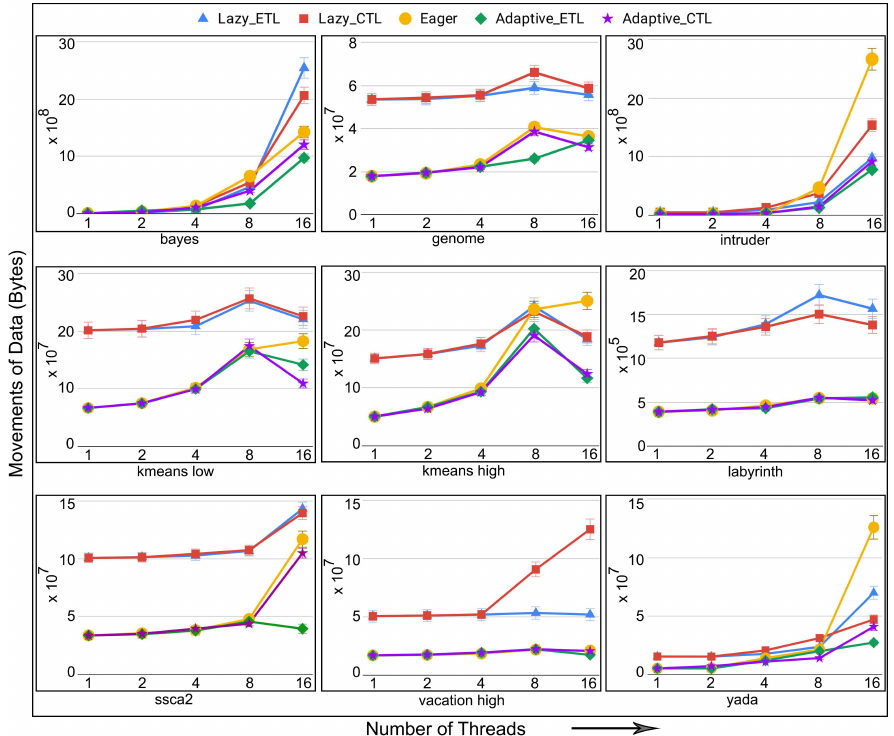
Figure 13. Data movements in STAMPEDE benchmarks executing in persistent TM.